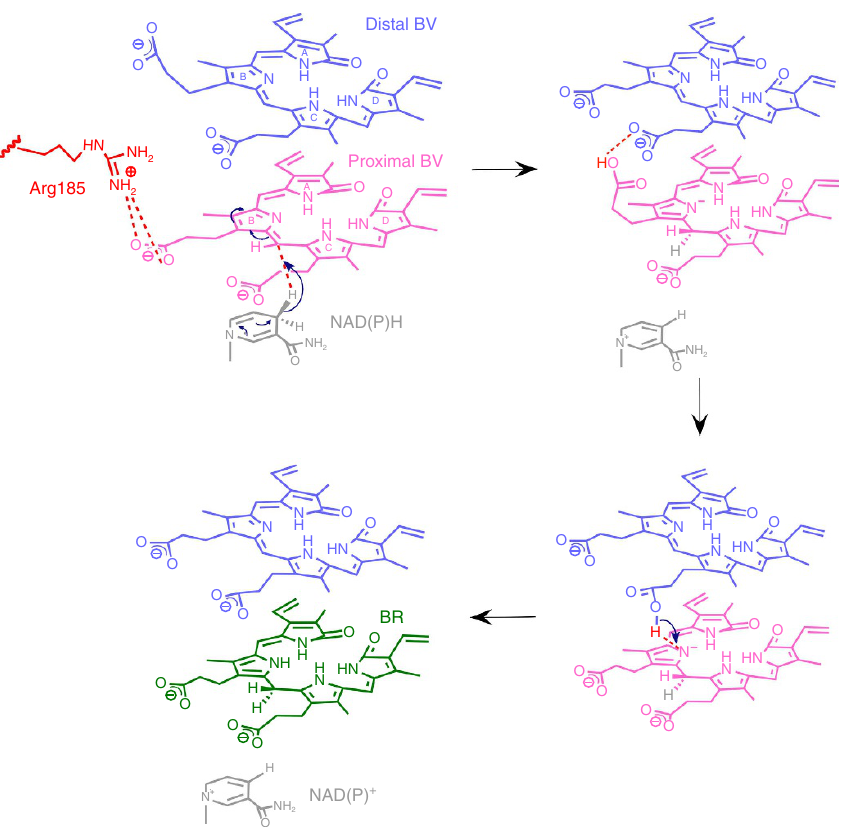
Figure 7 | Proposed mechanism of the BVR reaction. A hydride from NAD(P)H is directly transferred to the proximal BV, initiating the reduction of the proximal BV. The propionate side chain of the proximal BV accepts a proton from Arg185, subsequently, the proton is transferred to the propionate side chain in the distal BV, and the protonated propionic acid group in the distal BV moves toward the reducing site in the proximal BV to transfer the proton. Finally, the proximal BV accepts the proton to produce BR. Arrows in the nicotinamide and pyrrole rings indicate the electron flow, and in the other positions indicate the proton or hydride